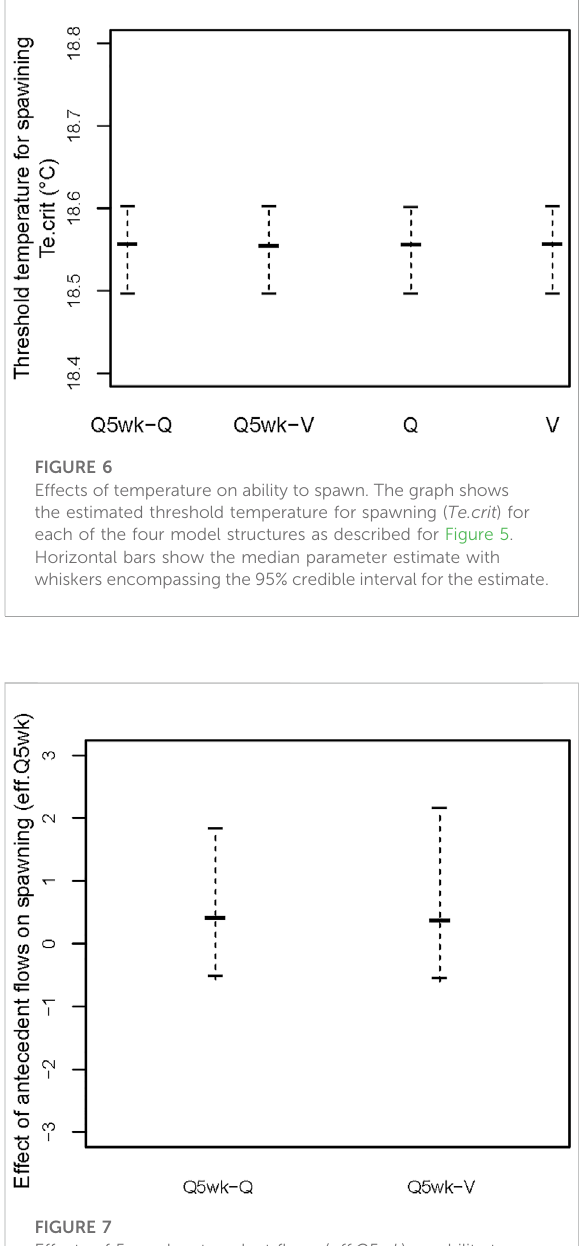
(Figure 8I vs. M, J vs. N, K vs. O, L vs. P). The estimate is less